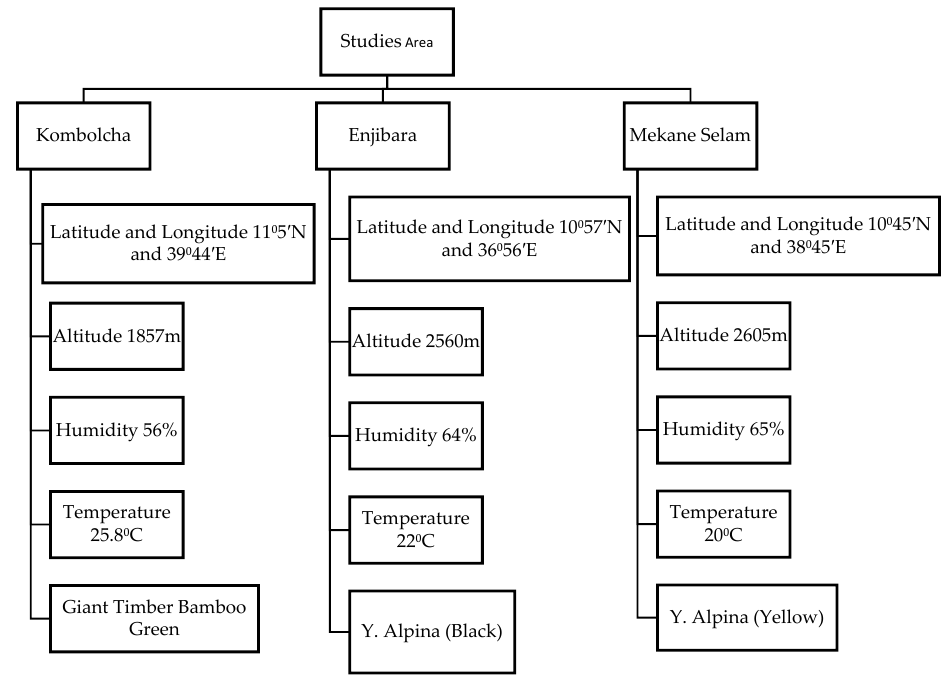
Figure 1. Description of the studied